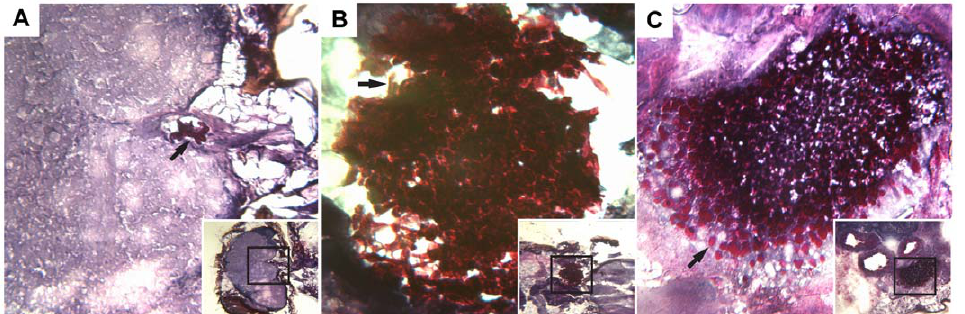
Figure 5. Histological evaluation of flies infected by stp1 D C.albicans . Despite exhibiting attenuated virulence, stp1 D mutant cells colonize many sites and exhibit diverse morphological forms. Flies were injected with C. albicans (PMRCA59) and three days post-infection, histological sections of infected flies were prepared. A. Infection in the head. B. Infection in the thorax. C. Infection in the abdomen. The large photographs in each panel are higher magnification views of the insets as indicated. Yeast-like (arrow; panel C), pseudohyphal (arrow; panel A), and hyphal cells (arrow; panel B) are observed. immune defense of the Tl mutant host, and clearly indicate that Tl mutant flies are not suitable for a nuanced analysis of fungal virulence traits.